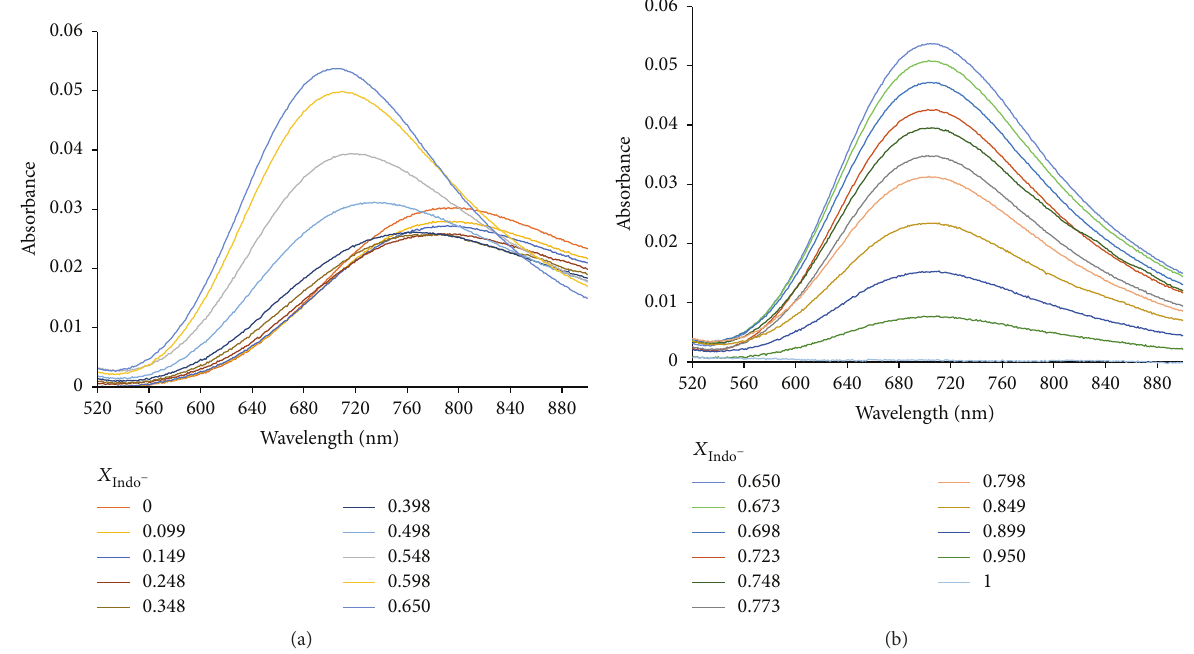
Figure 7: UV-Vis spectra of Cu(II)–Indomethacin in ethanol using the continuous variation method. (a) Absorption spectra for systems with ≤ 0.650 . (b) Absorption spectra for systems with 0.650 ≤ 𝑋 0 ≤ 𝑋 Indo −